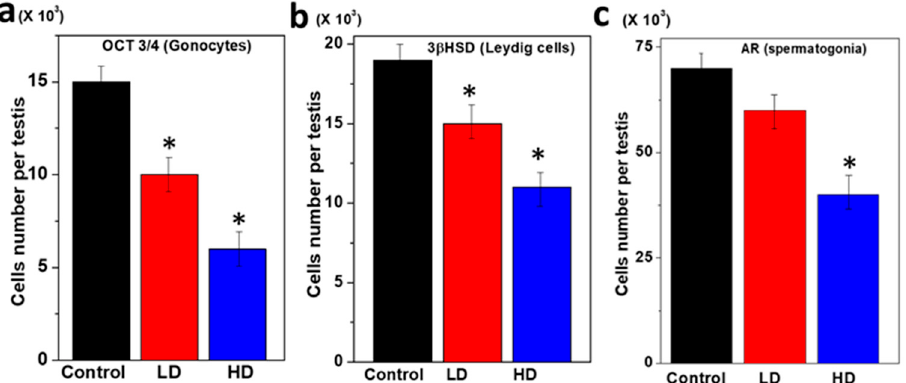
Figure 3. Immunofluorescent staining of germ cells of pup testes after 28 days of breastfeeding. ( a ) Immunopositive gonocytes for OCT 3/4. ( b ) Within the interstitial region of the same set of testes, 3 β - HSD-positive Leydig cells and ( c ) AR immunopositive peritubular cell populations.